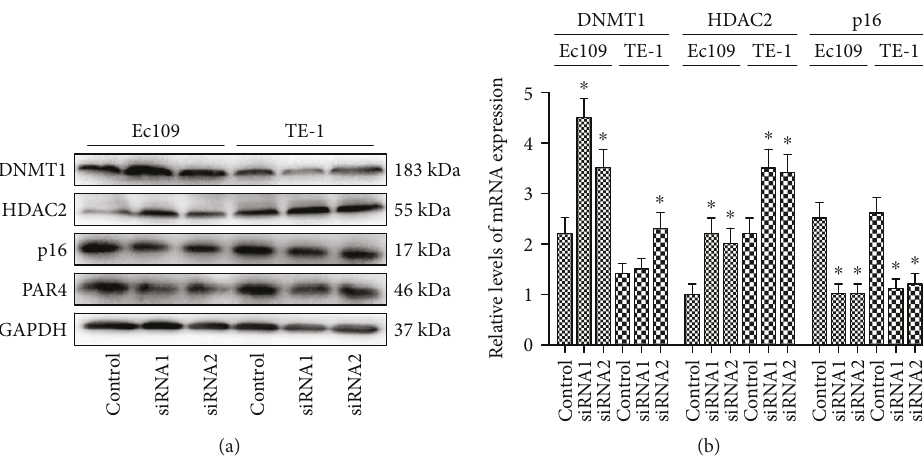
Figure 4: Silencing PAR4 induces DNMT1, HDAC2, and p16 expression in ESCC cells. (a) ESCC cells were transiently transfected with PAR4-siRNA1 or PAR4-siRNA2. Western blotting was performed to examine the expression of DNMT1, HDAC2, p16, and PAR4 at protein levels after transfection with PAR4-siRNA for 72h. (b) qRT-PCR was performed to examine the expression of DNMT1, HDAC2, and p16 expression at mRNA levels after transfection with PAR4-siRNA for 72 h. The results were calculated by normalizing to β -actin in the same sample with the Δ Ct method. The data are expressed as the mean ± SEM ( n = 3 ). ∗ P < 0 05 versus controls.